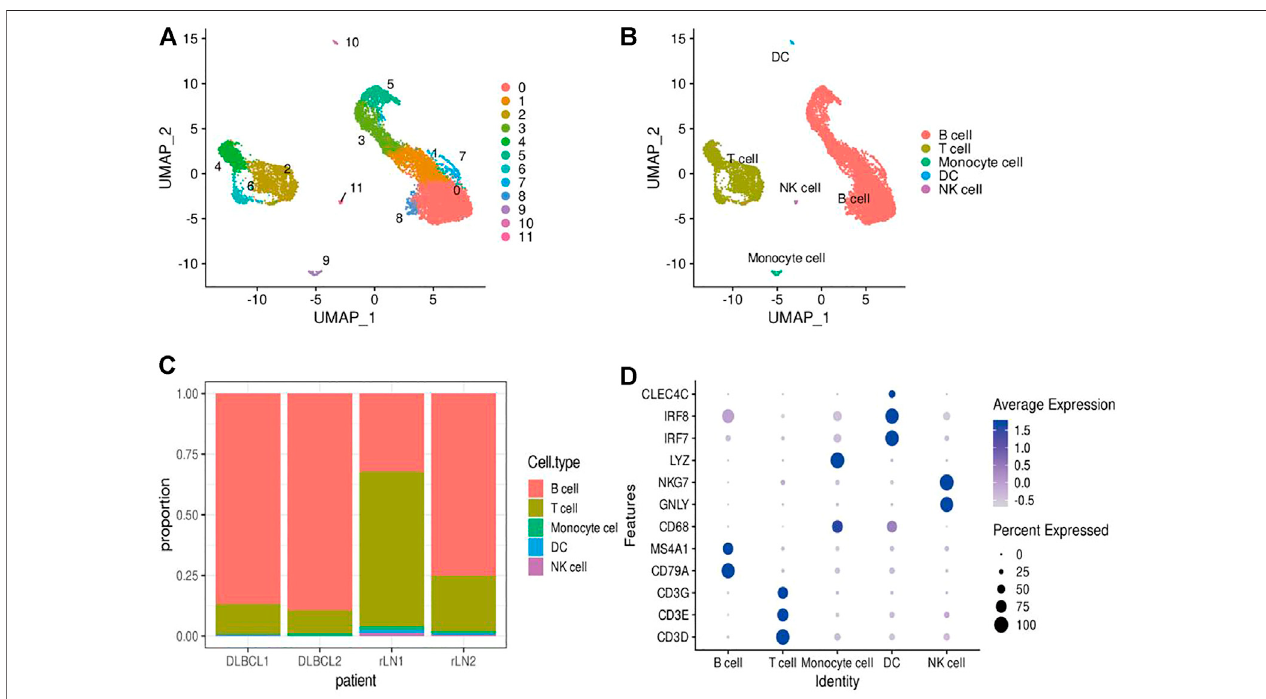
Figure 1B . Coloration was based on expression